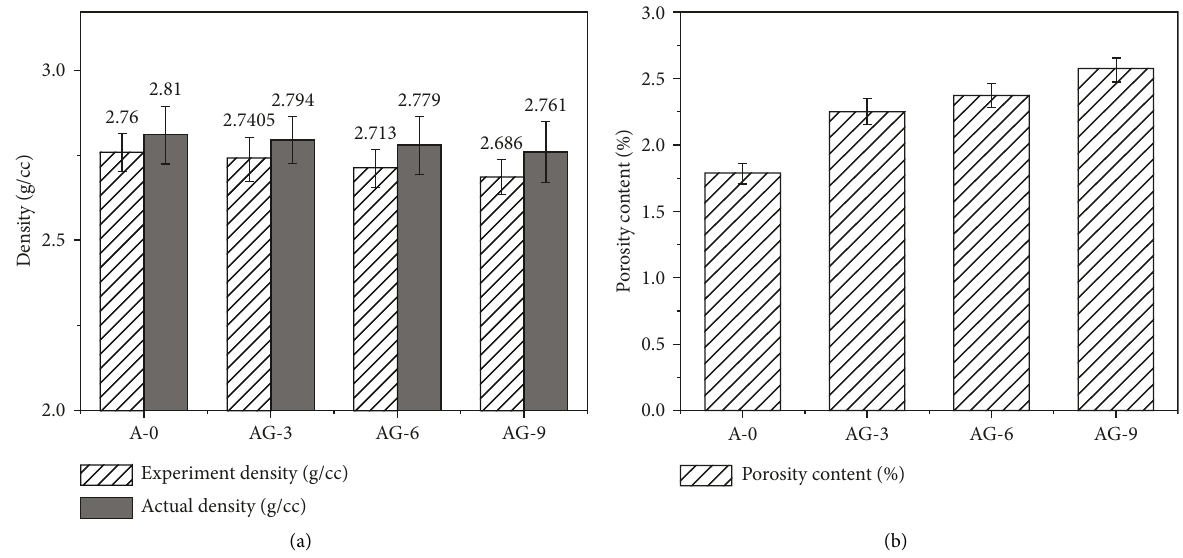
Figure 3: (a) Density variation and (b) porosity content of glass powder-reinforced aluminum matrix composite.